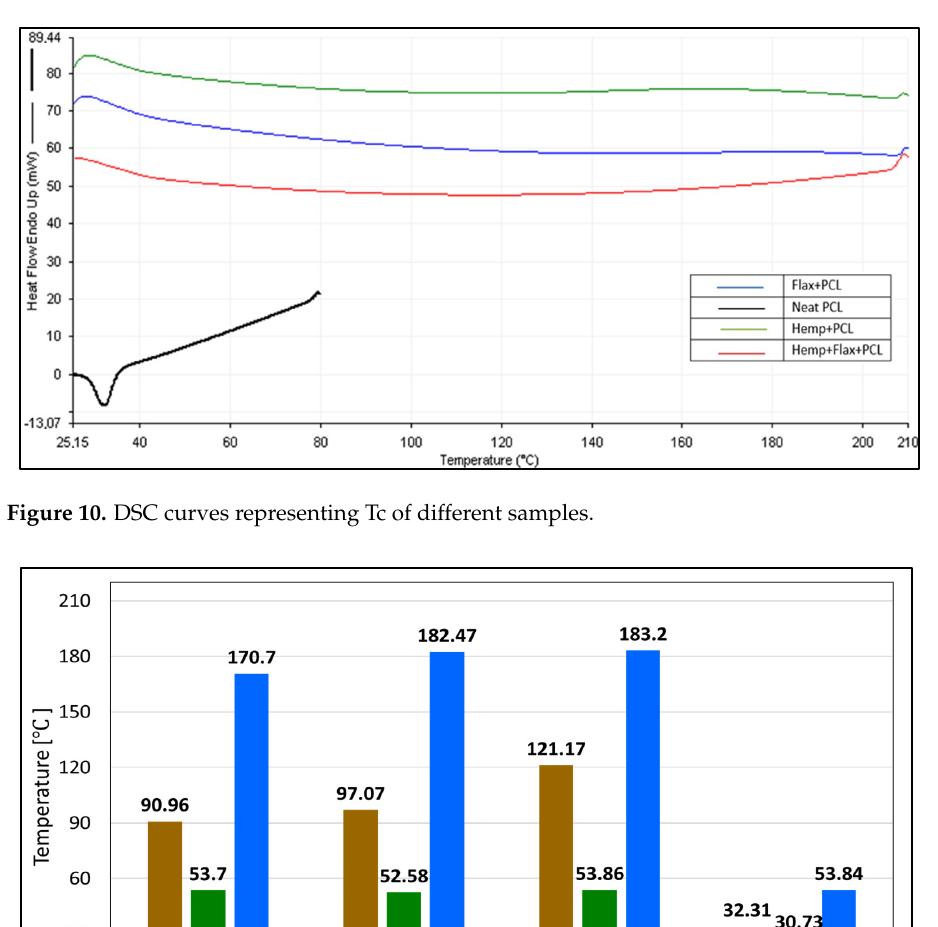
Figure 9. DSC curves representing Tg and Tm of different samples.